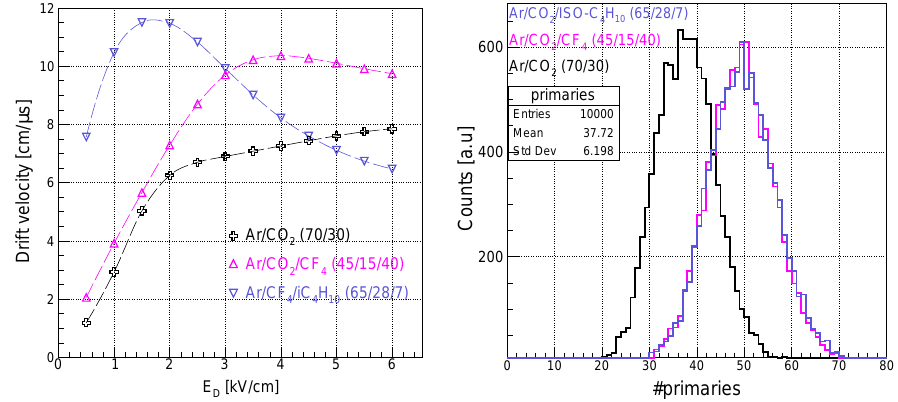
Figure 2. ( Left ) drift velocity vs. drift field ( E D ). ( Right ) number of primary clusters in 1 cm